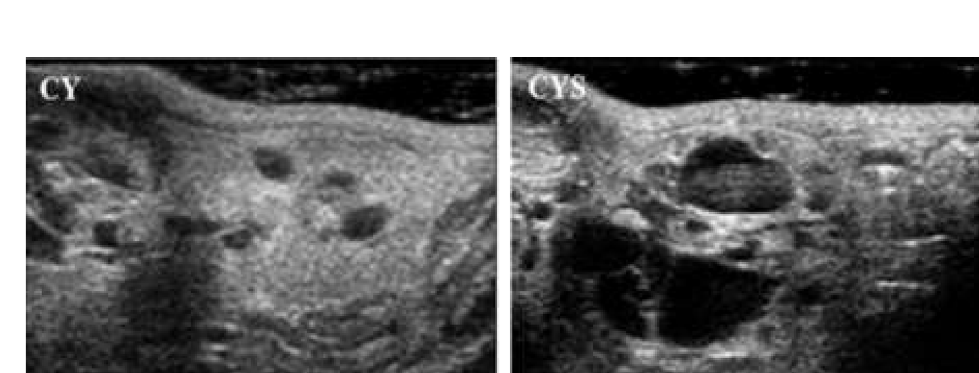
Figure 2. ( a ) Analysis of the effects of smoking and Pkd1 deficiency in SUN on NC (n = 6), NCS (n = 4), CY (n = 10) and CYS (n = 11) mice. ( b ) Analysis of the effects of smoking and the Pkd1 flox/- : Nestin cre genotype in the global renal cystic index on CY- Pkd1 flox/flox : Nestin cre (n = 8), CYS- Pkd1 flox/flox : Nestin cre (n = 6), CY- Pkd1 flox/- : Nestin cre (n = 3) and CYS- Pkd1 flox/- : Nestin cre (n = 5) mice. These analyses were performed using aligned rank transform followed by two-way analysis of variance. ( c ) Representative images of the renal cystic phenotype in the absence and presence of